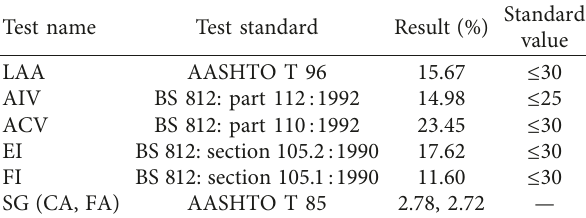
Table 1: Physical properties of